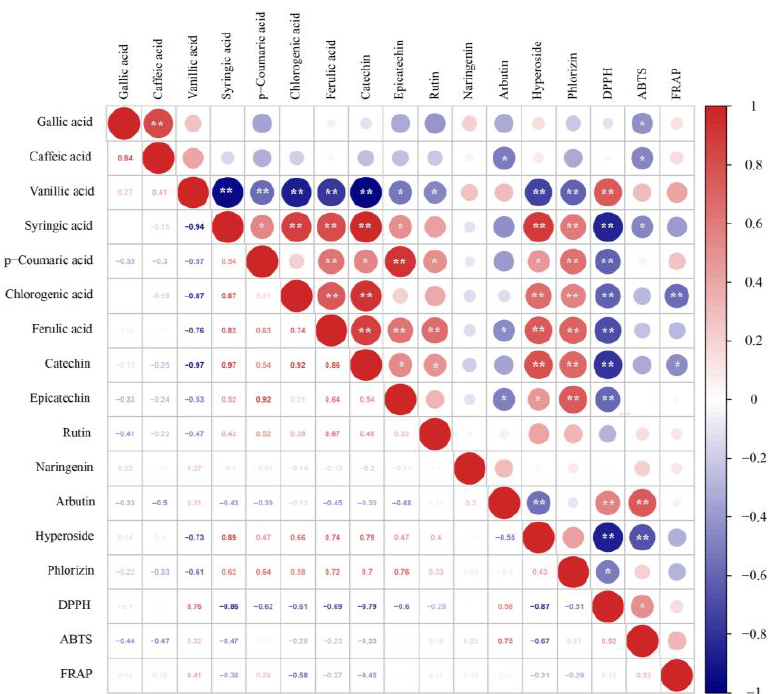
Figure 4. Heat map of Pearson correction coefficient for heat map of phenolics profile and antioxidant activities. * Correlation is significant at p < 0.05. ** Correlation is significant at p < 0.01.